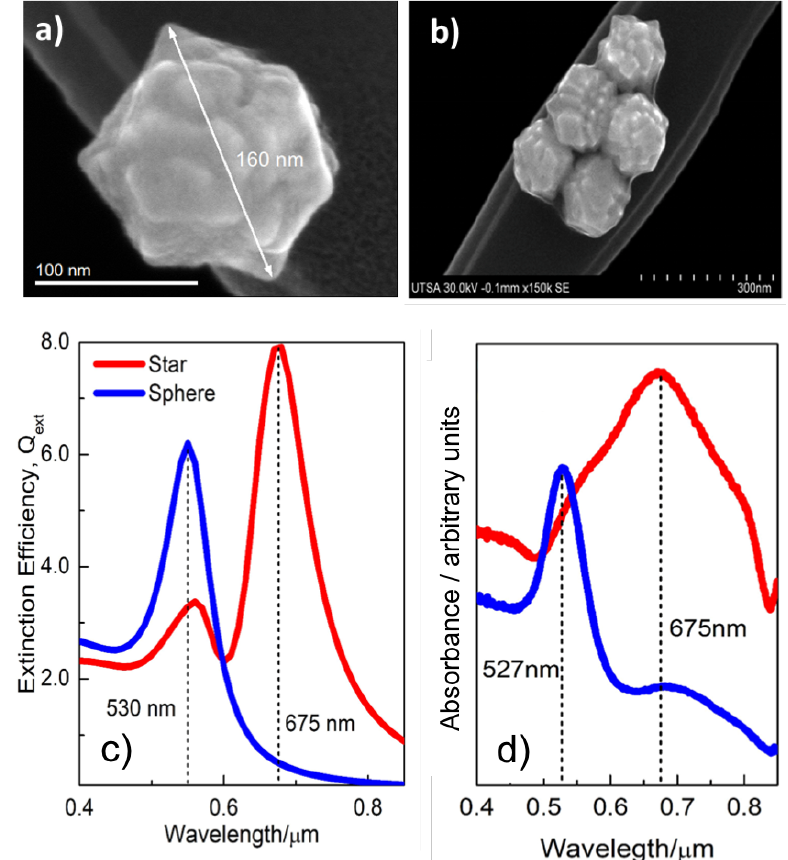
Figure 1. ( a ) Scanning electron micrograph of a gold nanostar with a diameter of about 160 nm. The diameter distribution shows a median value of 159 nm with a standard deviation of 3 nm. ( b ) Clustering of gold nanostar that will be present in the colloid. ( c ) Extinction coefficient evaluated through numerical simulations of both nanospheres (blue) and nanostars (red). ( d ) Measured